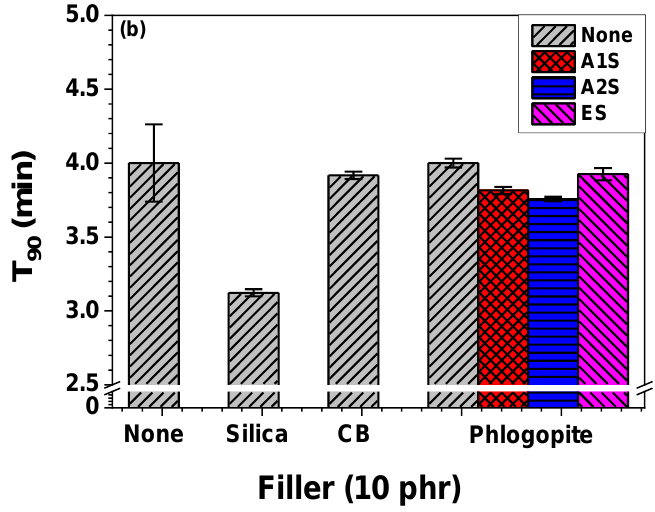
Figure 2. ( a ) Mooney viscosities and ( b ) T 90 of the pristine NR/EPDM blend and filler-embedded NR/EPDM composites with different compatibilizers.